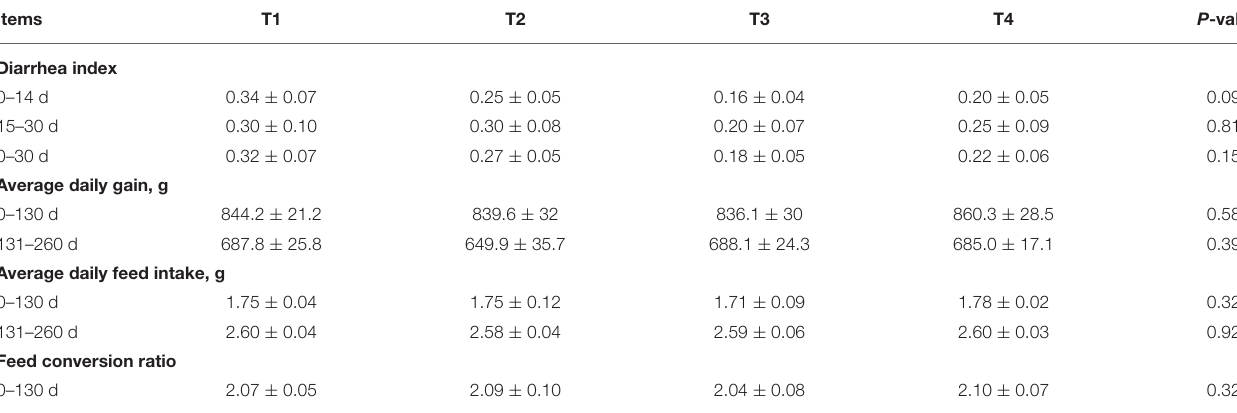
TABLE 2 | Effect of dietary fiber and metabolites on diarrhea and growth performance of boars. Items